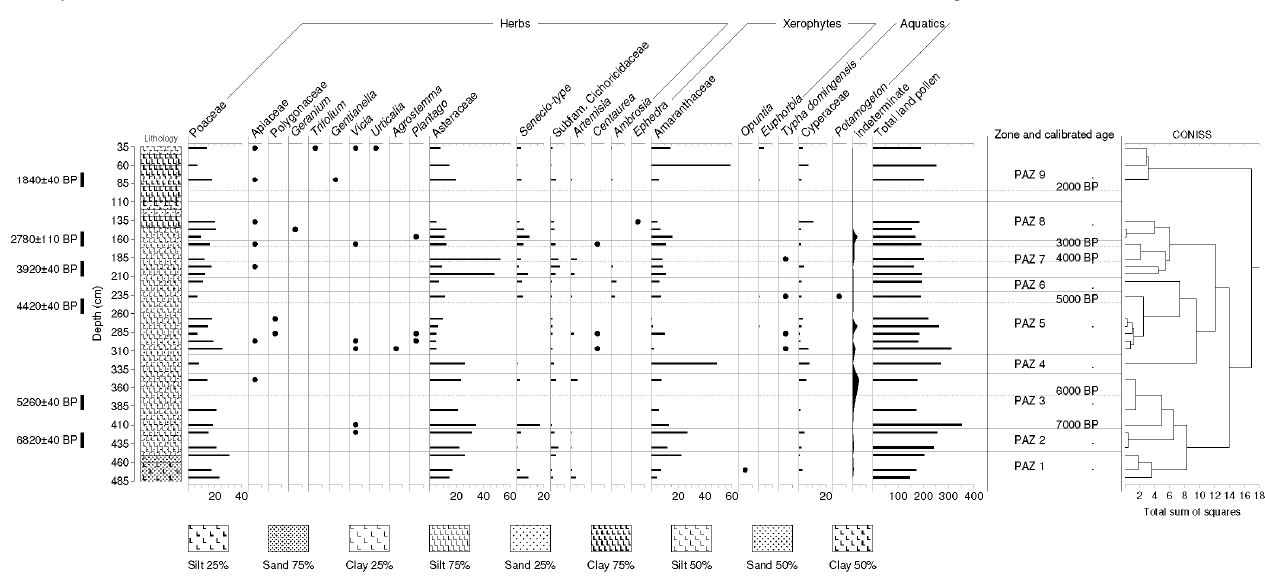
Figure 5. Buckeye Knoll (BK) relative pollen diagram (non-arboreal pollen as percentage of TLP) and Troels-Smith lithology. Note redox (red coloration) features.